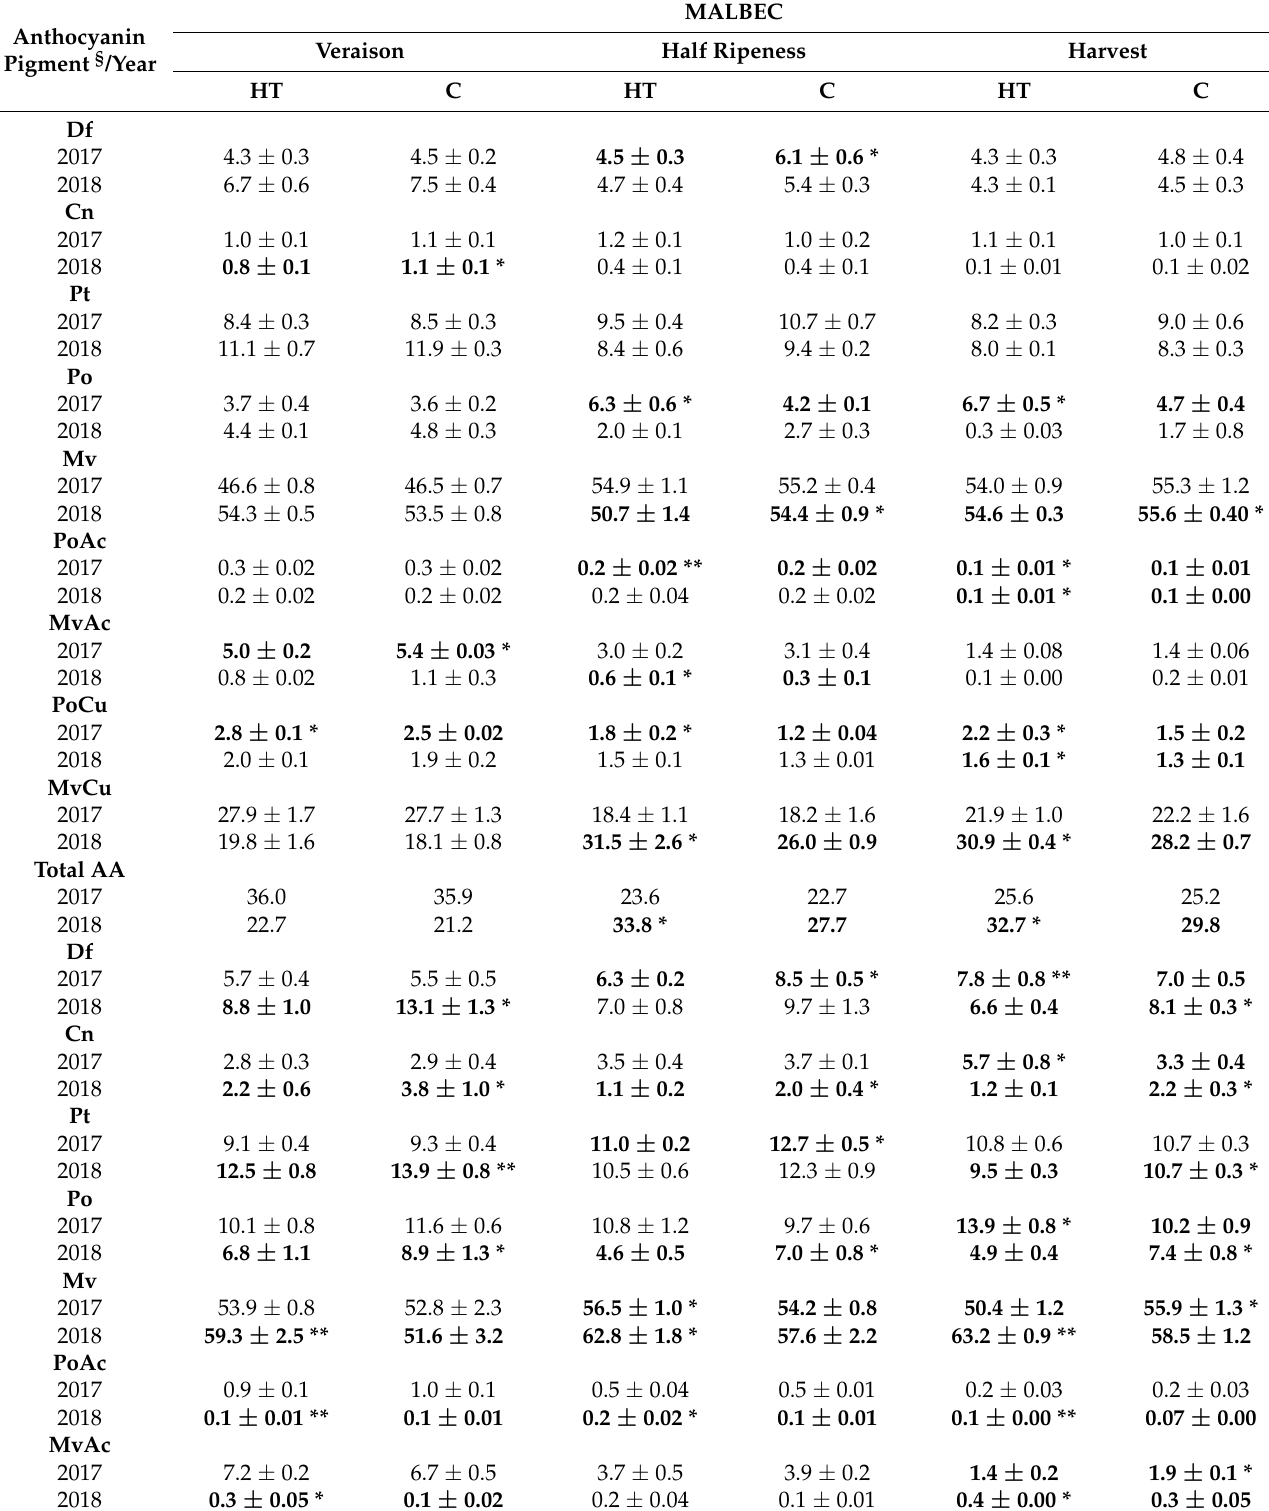
Table 3. Relative content (%) of nine anthocyanin pigments in berries of Malbec, Merlot, and Pinot Noir plants grown under high (HT) and control temperature (C) conditions during the fruit ripening